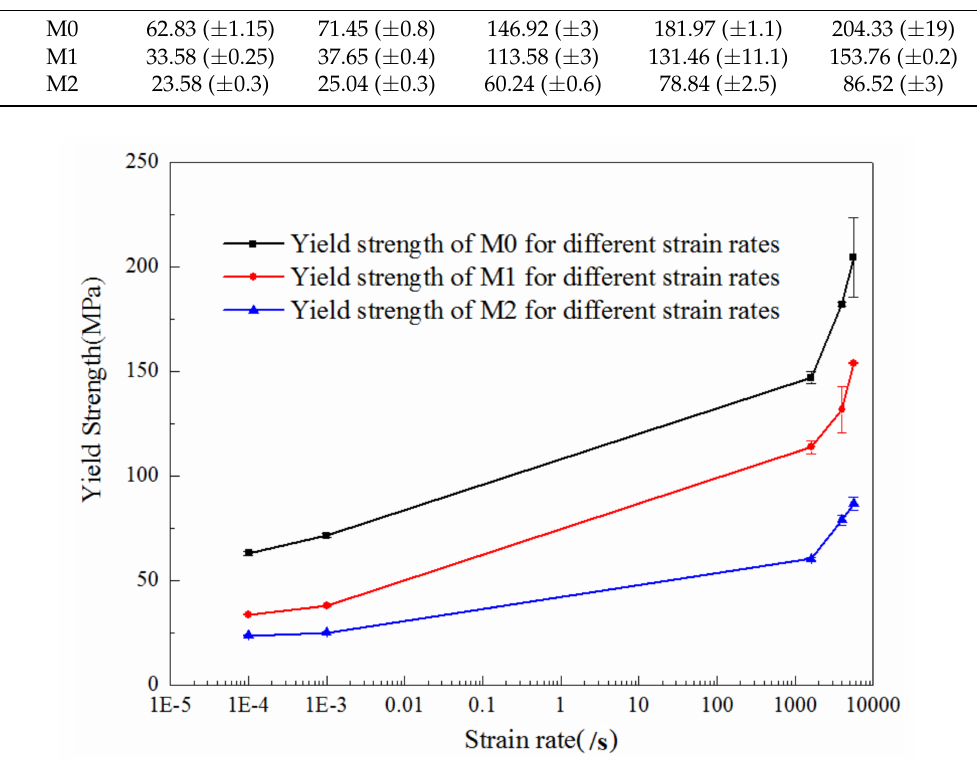
Figure 7. Yield strengths of specimens with different LNBR content: 0% (M0), 10% (M1), 25% (M2) under different strain